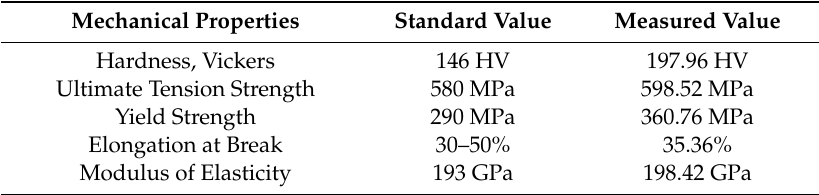
Table 2. The mechanical property of AISI